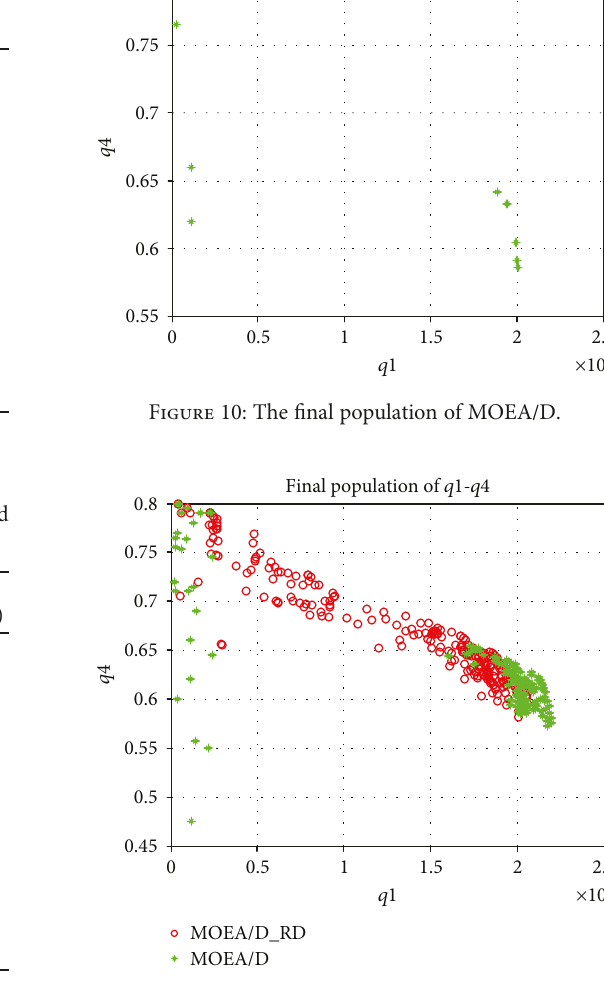
Figure 11: The fi nal population of MOEA/D_RD and MOEA/D.